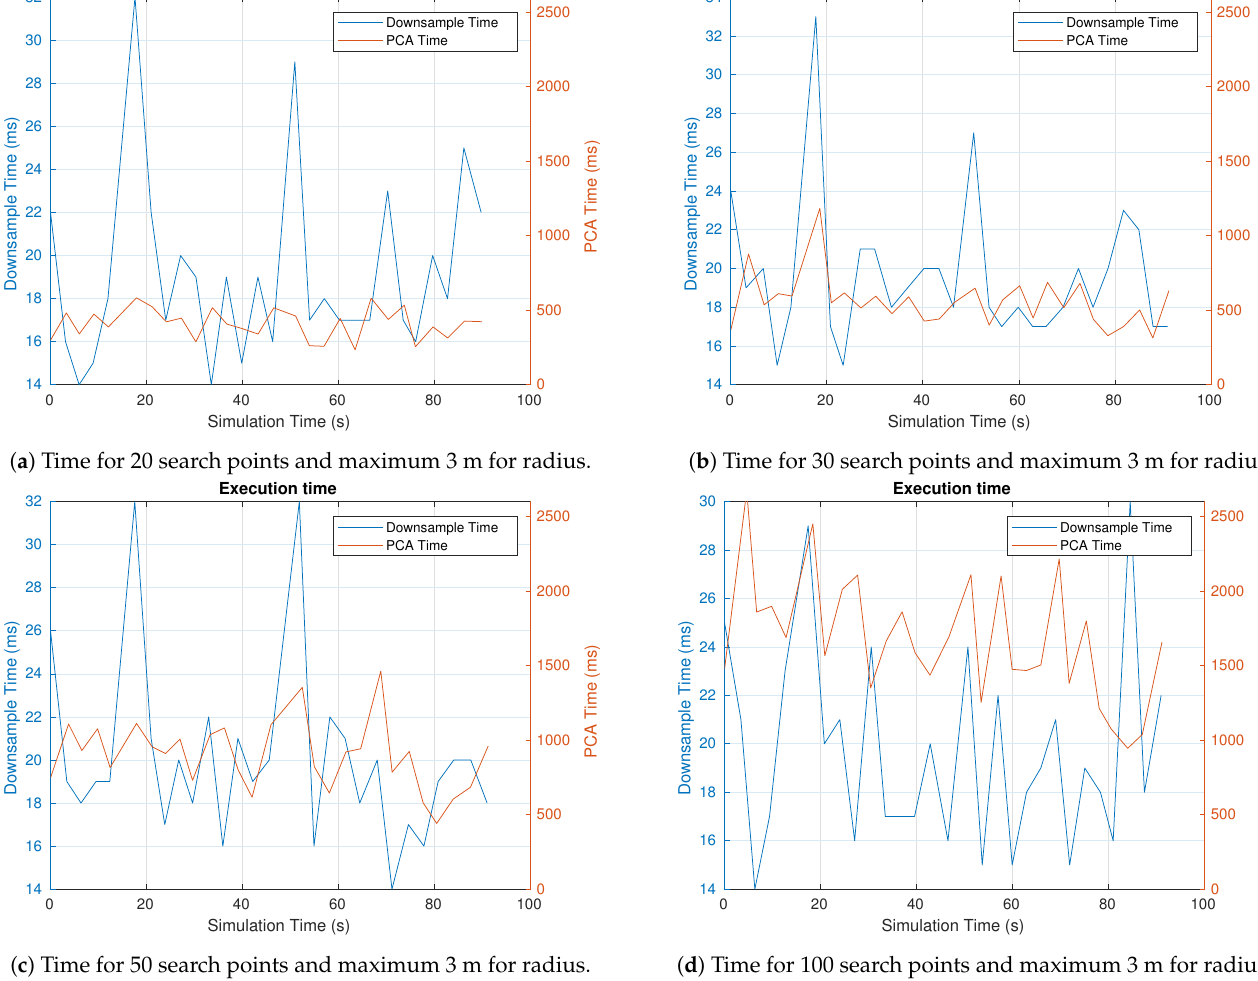
( d ) Time for 100 search points and maximum 3 m for radius. Figure 7. Comparison between downsampling and PCA execution time for the first